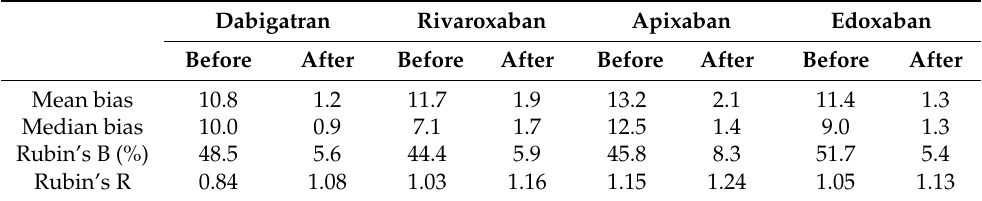
Table 1. Comparisons of each NOAC cohort with warfarin patients before and after Kernel weighting: mean and median bias, Rubin’s B and Rubin’s R. Dabigatran Rivaroxaban Apixaban Edoxaban